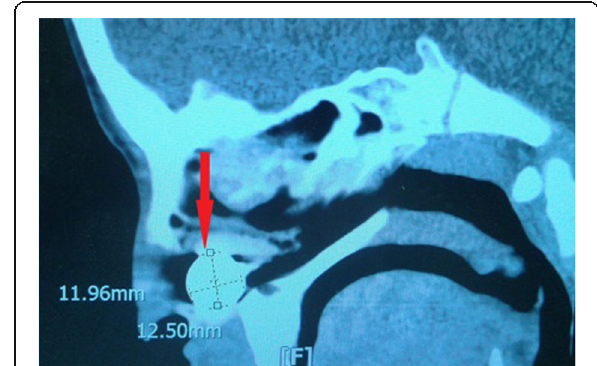
Fig. 3 Nasal foreign body (watch battery) lead to orbital cellulitis, Orbital CT scan sagittal view showed a metallic foreign body in the nasal cavity